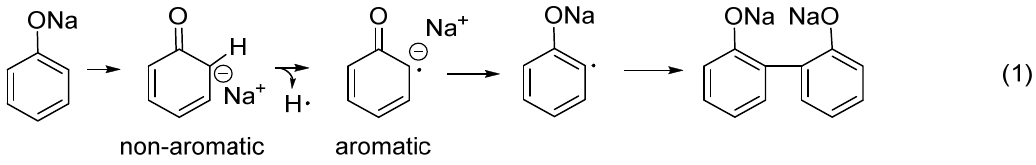
Scheme 1. Cleavage of Ar-H bond and generation of biphenolates.